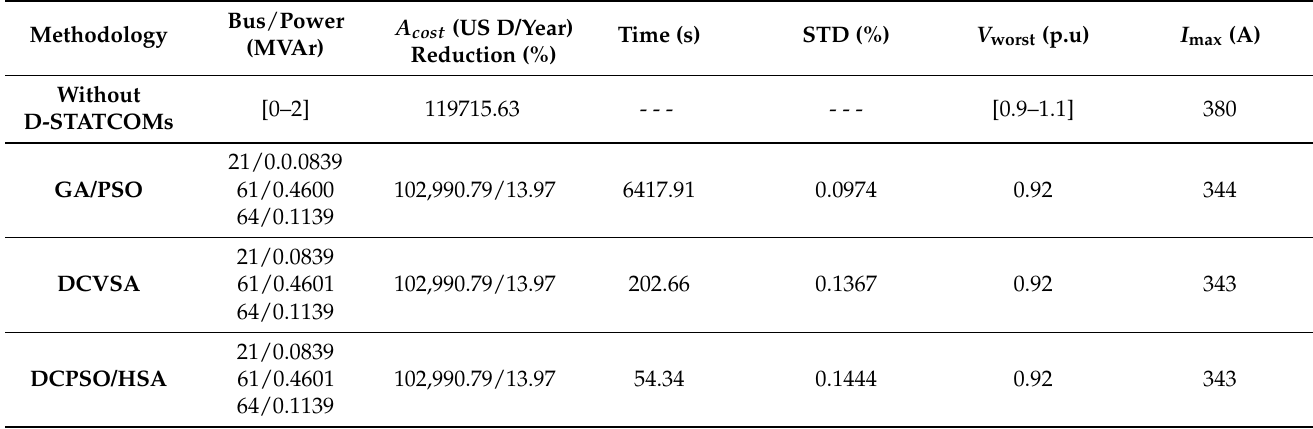
Table 4. Simulation results obtained by different methodologies in the 69-bus test system.